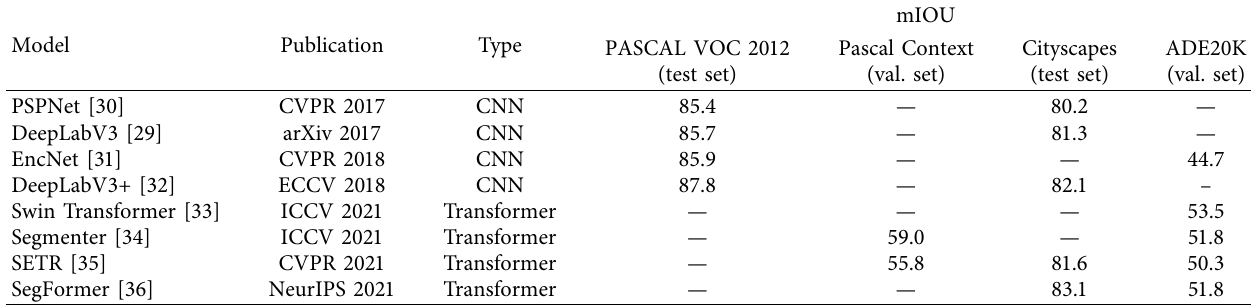
Table 1: Comparison of state-of-the-art deep learning models in four high-level semantic segmentation datasets. Note that numeric data filled in this table refers to mIOU evaluation results collected from original